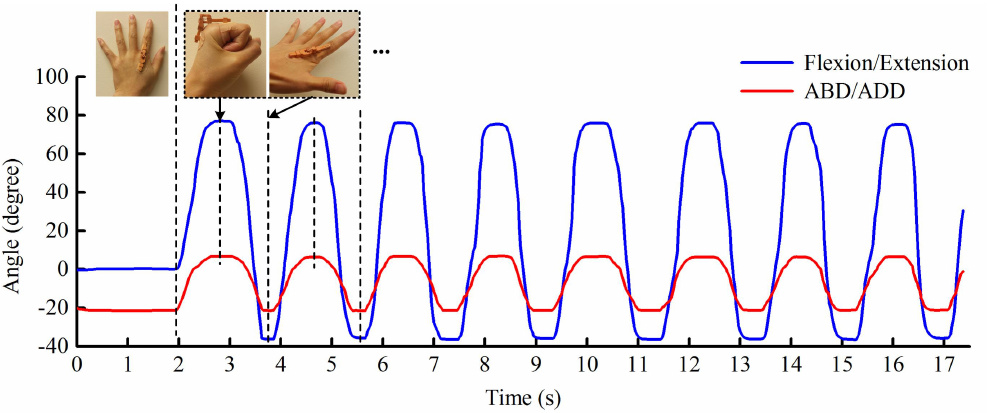
Figure 8. The simultaneous movements of the flexion/extension and abduction/adduction (ABD/ADD) of the metacarpophalangeal joint of the participant’s left index finger. The actions in the dotted box are repeated